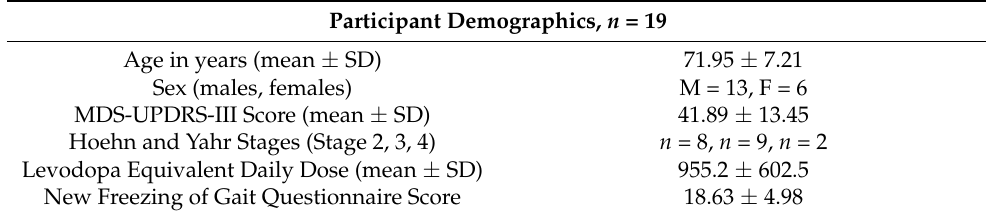
Table 1. Participant Demographics, n = 19.